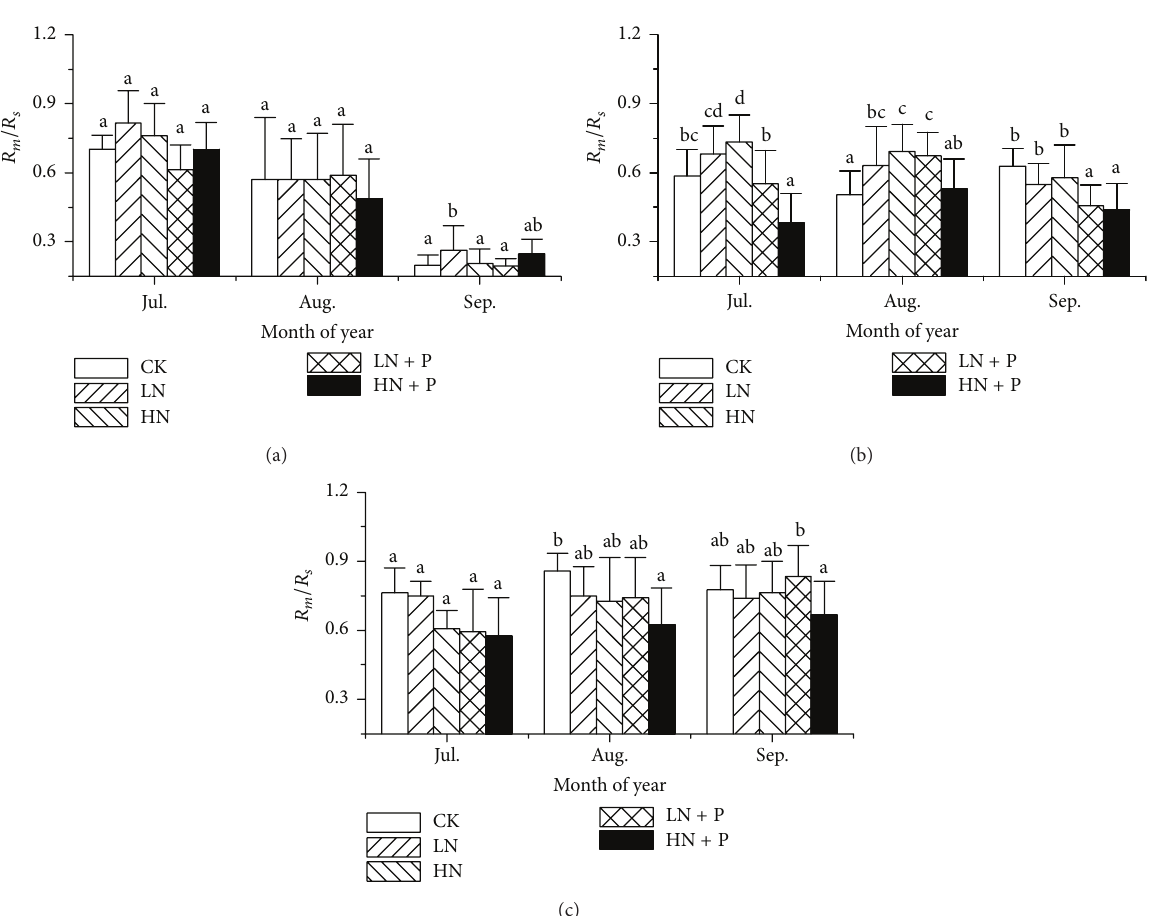
Figure 2: The contribution of soil microbial respiration ( 𝑅 𝑚 ) to soil respiration ( 𝑅 𝑠 ) in every July, August, and September during the 2010, 2011, and 2012 growing seasons in different fertilization treatments. See Figure 1 for